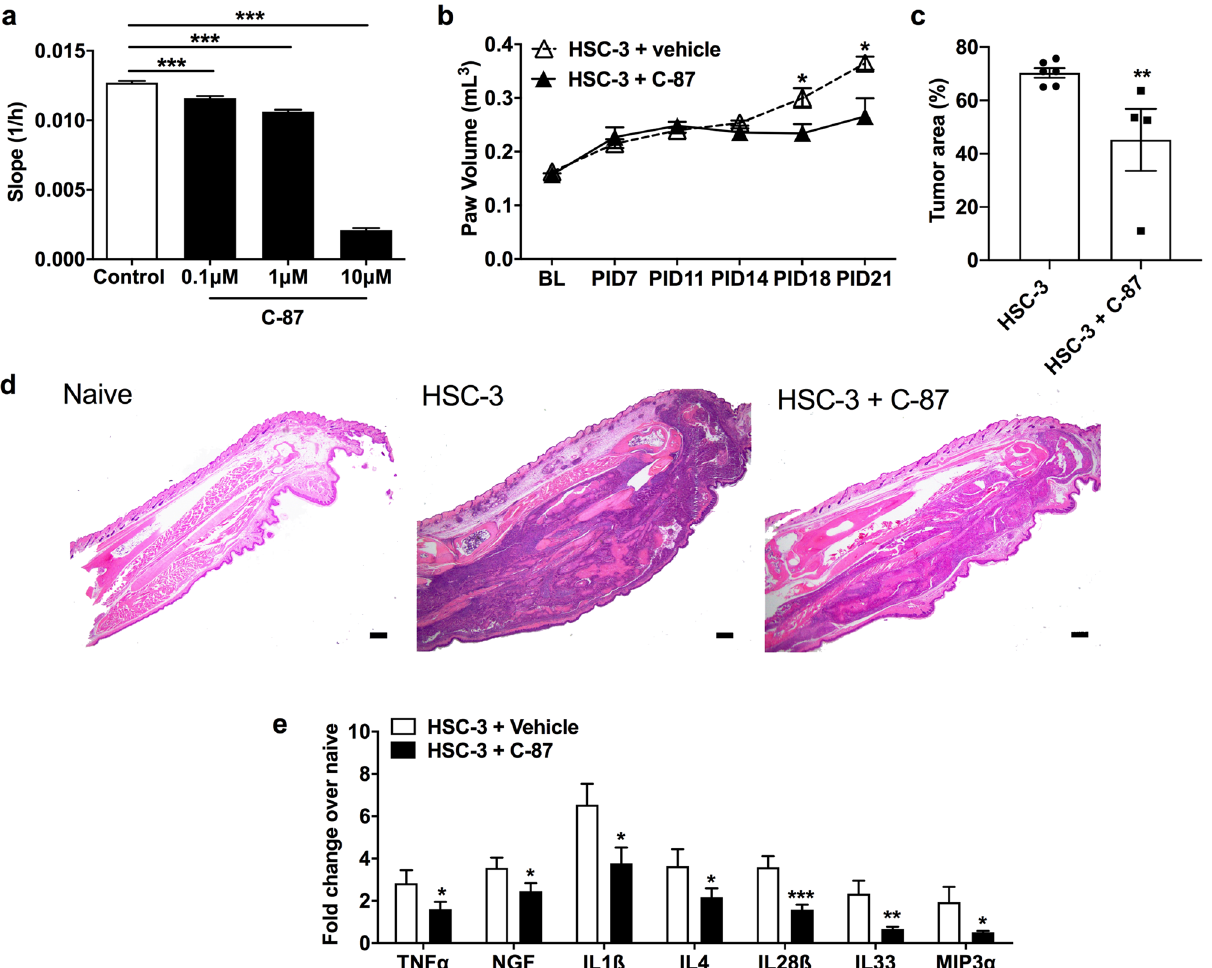
Figure 3. Blocking TNFα inhibits cancer cell growth, migration, and cytokine release. ( a ) Growth rate, measured with the RTCA, following different doses of C-87 treatment in HSC-3 cell culture. C-87 inhibited oral cancer cell growth in a dose dependent manner. One-way ANOVA with Tukey’s post hoc analysis. ( b ) Mice with C-87 treatment (n = 7) exhibited a significant decrease in the paw volume compared to the vehicle control mice (n = 6) at PID14, 18, and 21 (two-way ANOVA). Arrow indicates C-87 injection. ( c ) C-87 treated paw cancer mice (n = 6) had smaller tumor area relative to the total paw area compared to vehicle treated paw cancer mice (n = 4). Tumor areas and total paw areas were quantified using H&E stained paw sections. Mann– Whitney U-test. ( d ) Representative H&E stained pictures showing a normal mouse paw, a cancer mouse paw, and a cancer paw treated with C-87 (10 × inset). Scale bar: 100 μm. Images were taken and quantified using Nikon imaging software NIS-Elements F Ver4.60.00. ( e ) C-87 treatment reduced the concentration of TNFα, NGF, IL1β, IL4, MIP3α, IL28β, and IL33 in the paw tumor. Data were presented as fold change of cytokines/ chemokines measured from tumor paws over normal paws. n = 6 per group. Mann–Whitney U test. * P < 0.05; ** P < 0.01; *** P <